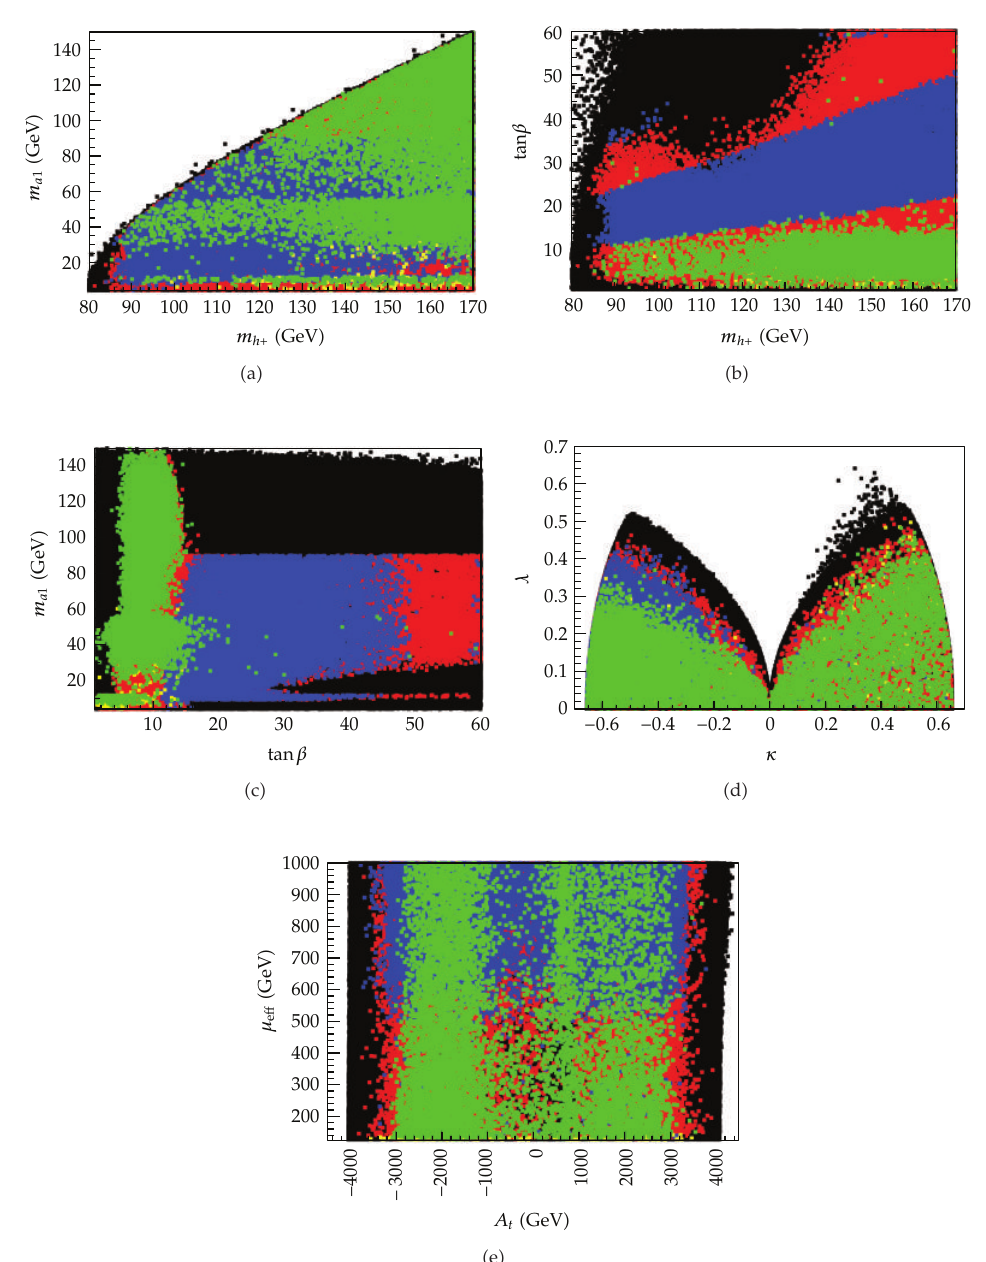
Figure 1: Correlations between the parameters of the scan in the scenario under consideration (cid:2) see text for details (cid:3) with the various constraints applied as follows. All points in black are viable model points but are excluded by HiggsBounds. The coloured points are allowed by HiggsBounds and plotted in the following order: red points are excluded by B s → μ (cid:8) μ − , blue points are excluded by B u → τ (cid:8) ν τ , yellow points are excluded by direct searches for supersymmetric particles, and finally green points are allowed by all constraints